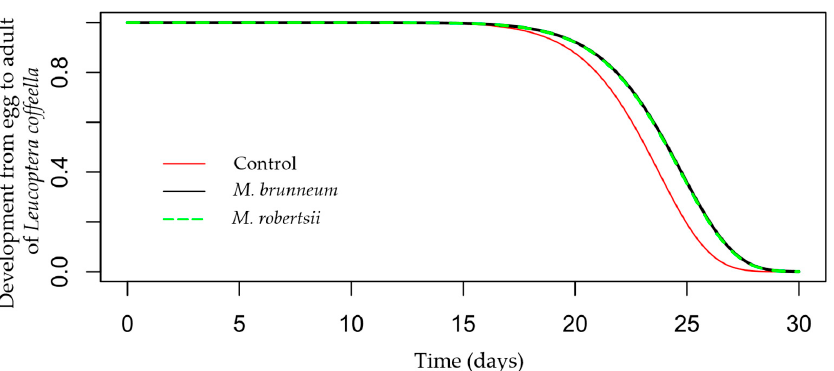
Figure 3. Developmental time from egg to adult of Leucoptera coffeella in coffee seedlings inoculated with Metarhizium robertsii and Metarhizium brunneum by soil drench. Inoculation of 30 mL of each isolate suspension was to the surface of the soil in each coffee seedling while the control received a sterile solution of Tween 0.05%.